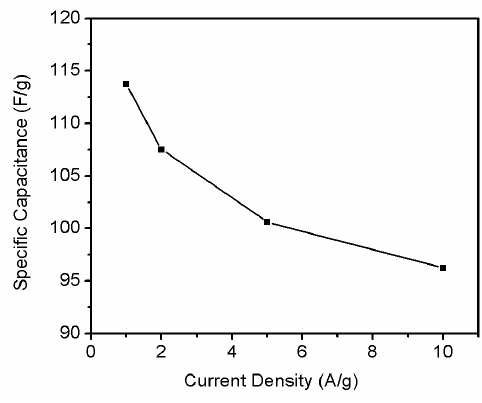
Figure 11. Speci fi c capacitance of the symmetric supercapacitor at various current densities in 2 M KOH.